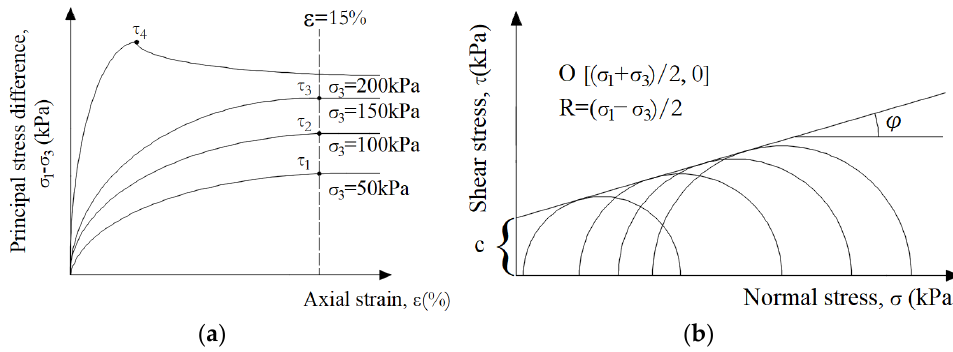
Figure 10. The schematic diagram of the soil shear strength parameter calculation. ( a ) Stress–strain curve. ( b ) Mohr’s circle.